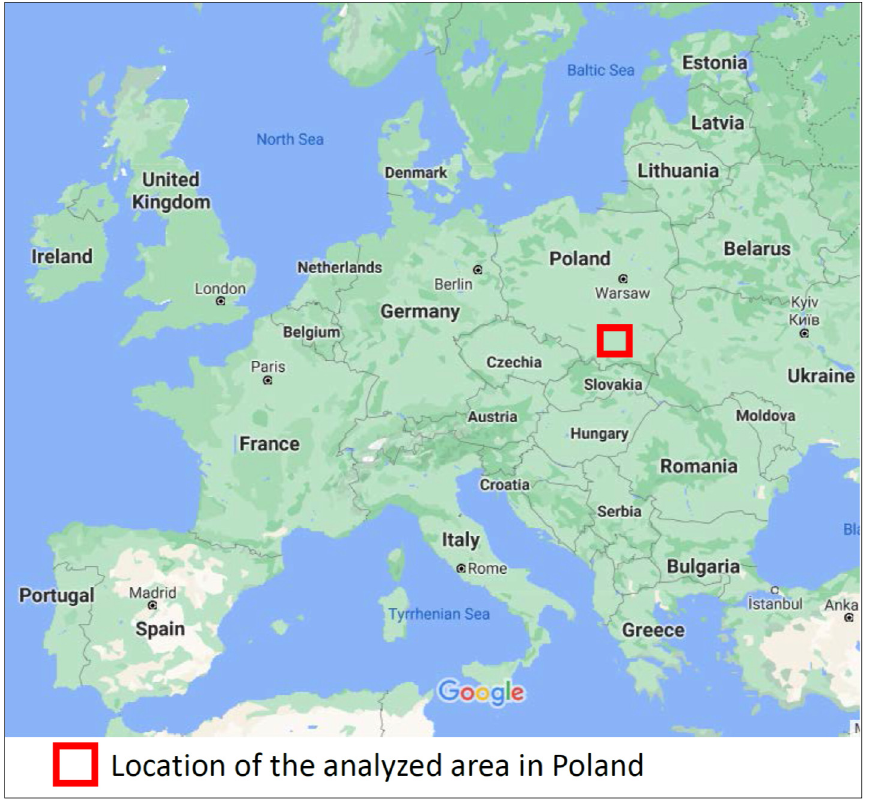
Figure 1. Location of the analyzed area in Poland on the background of the map of Europe (source: Google Maps).